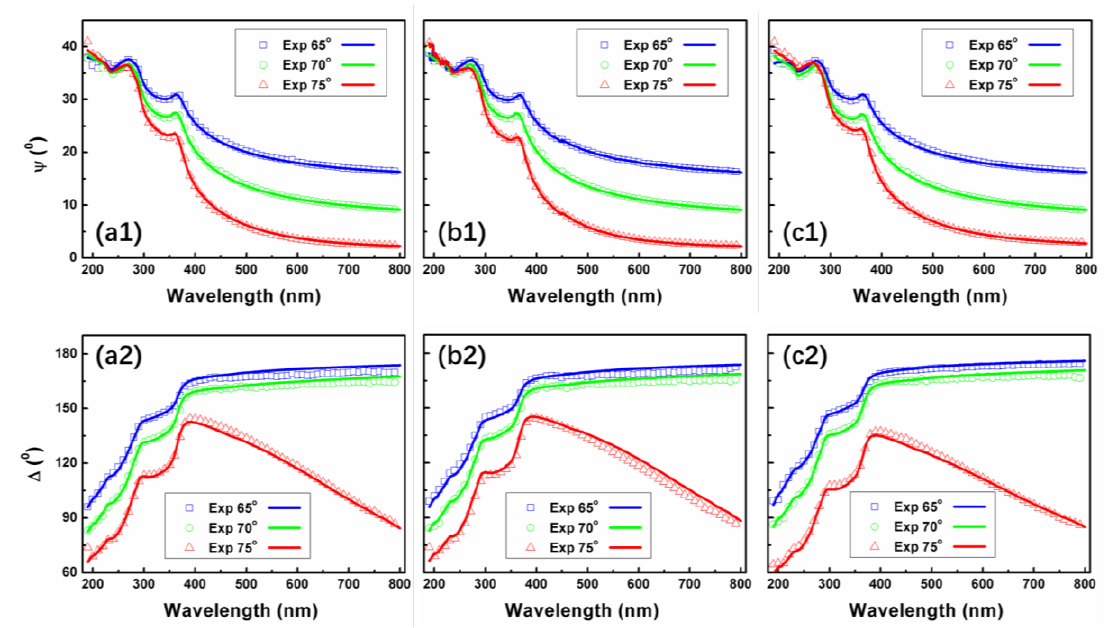
Figure 7. Ellipsometry measured and simulated Ψ ( a1 , b1 , c1 ) and ∆ ( a2 , b2 , c2 ) for SiON samples for angles of incidence of 65°, 70°, and 75°.